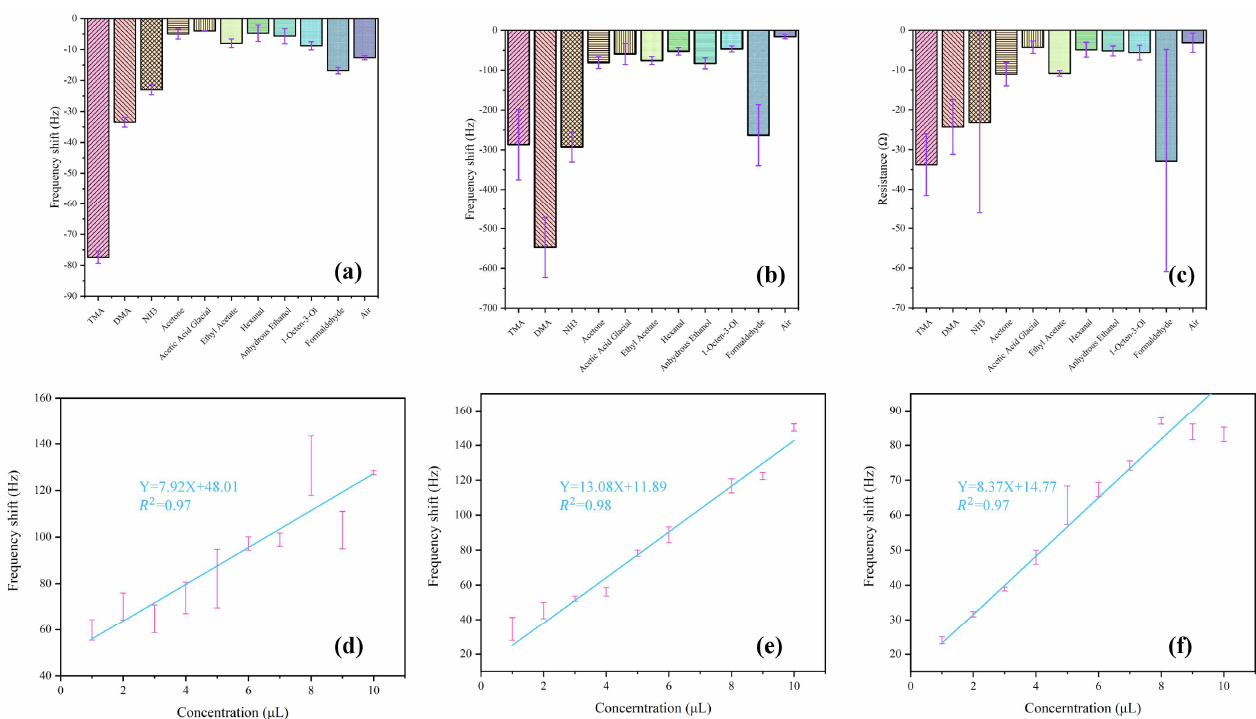
Figure 6. Selectivity of GO and NGO-functionalized QCM sensors to different gases. ( a ) Frequency response of the GO-based QCM sensor, ( b ) frequency response of the NGO-based QCM sensor, ( c ) resistance response of the NGO-based QCM sensor, ( d ) response amplitude regression curves of the NGO/Au Nps-based QCM sensor, ( e ) response amplitude regression curves of the NGO/Ag Nps-based QCM sensor, and ( f ) response amplitude regression curves of the GO/Ag Nps-based QCM sensor.